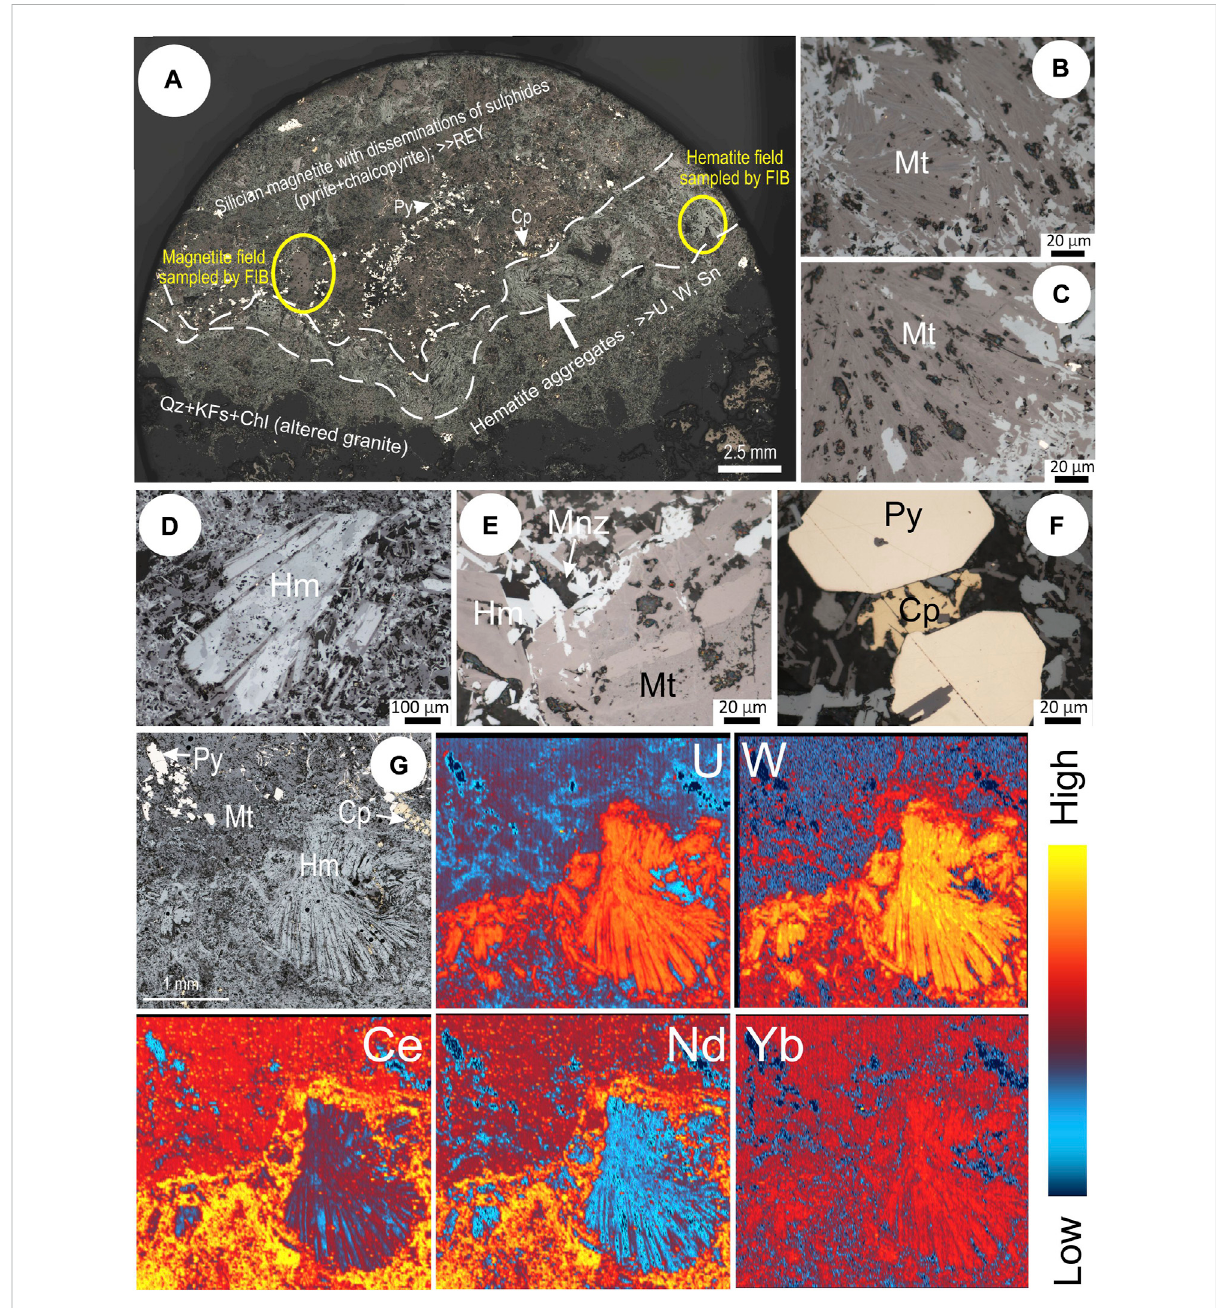
FIGURE 1 (A – F) Photomicrographs in re fl ected light. (A) Overview of magnetite-hematite-bearing sample CLC21, as labelled. (B) Lamellar silician magnetite underlined by sub-micron-sized Si-bearing inclusions. (C) Partial pseudomorphic replacement of silician magnetite by hematite. (D) Coarse aggregate of lamellar ‘ bladed ’ hematite. (E) Monazite inclusions (Mnz) clustered within fi ne-grained hematite and magnetite. (F) Subhedral pyrite (Py) with chalcopyrite (Cp) in pressure shadow. (G) Re fl ected light image (top left) and selected LA-ICP-MS element maps of boundary domain between lamellar hematite and silician magnetite. Note relative enrichment of W and U in hematite relative to silician magnetite and relative LREE enrichment (Ce and Nd) in silician magnetite. HREEs (represented here by Yb) are evenly distributed across both